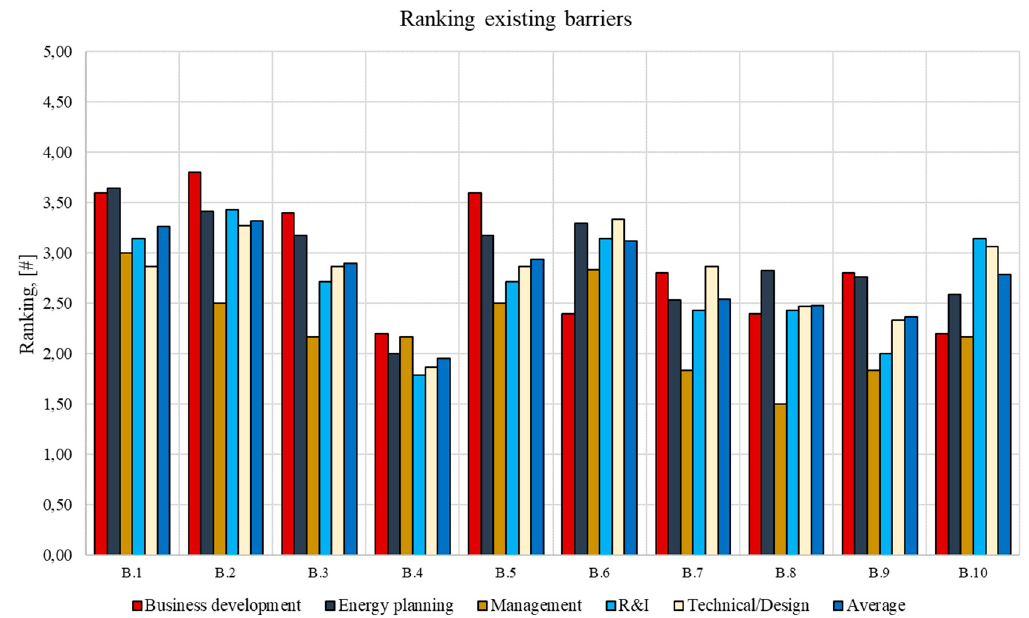
Figure 31. Ranking of the identified existing barriers as a function of the employment Figure 31 . Ranking of the identified existing barriers as a function of the employment role.